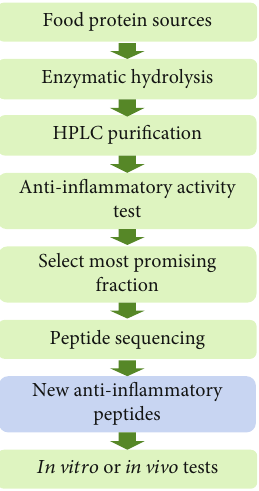
Figure 1: Classical steps toward the production and puri fi cation of anti-in fl ammatory peptides from food protein sources. HPLC: high- performance liquid chromatography. This fi gure was adapted from previous reports [3, 48,